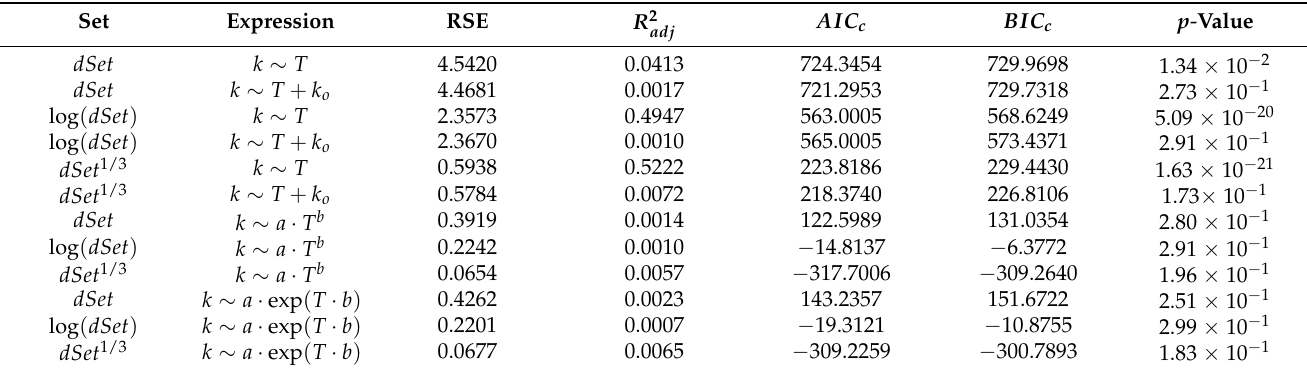
Table 6. Regression results for k vs. T for the CMC dataset.